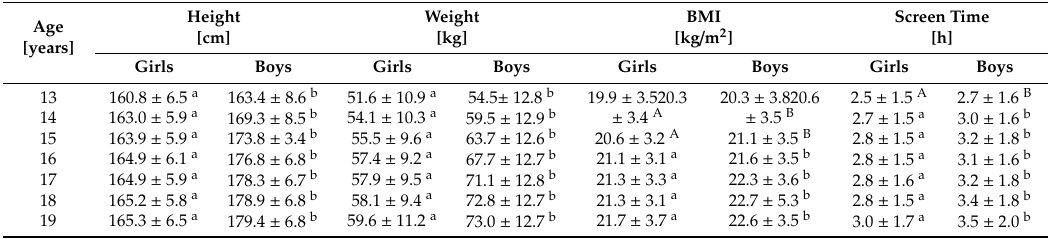
Table 1. Descriptive statistics: anthropometric data and the average screen time duration (all data expressed as mean ±